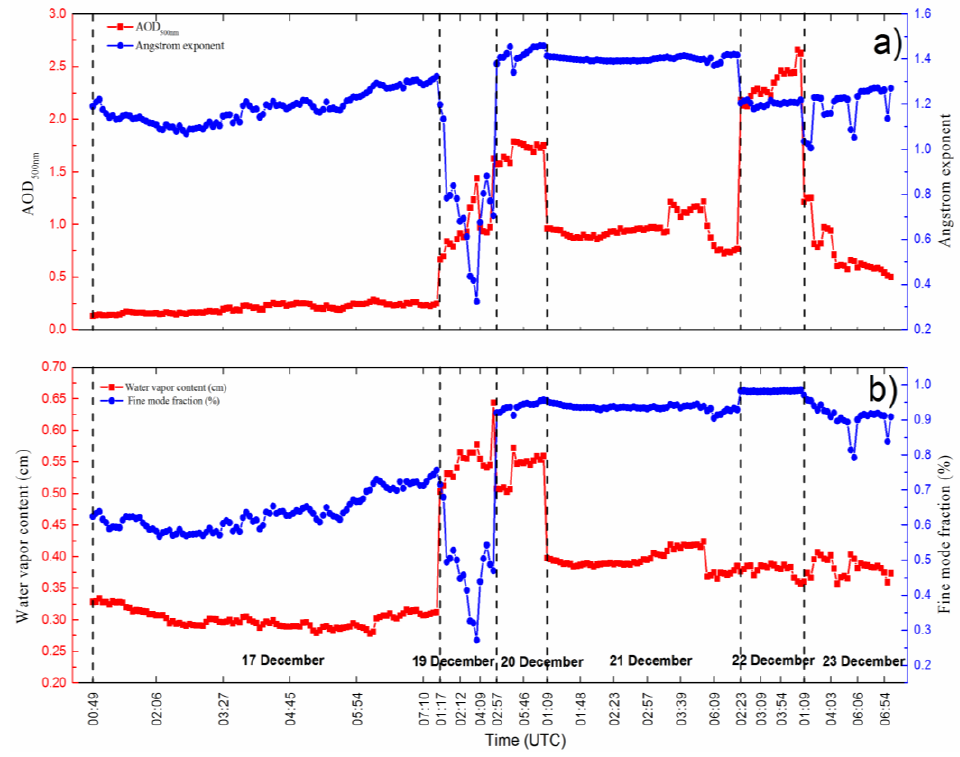
Figure 5. Daily variation of ( a ) AOD 500nm and AE; and ( b ) CWV and FMF (Level 1.5 aerosol inversions datasets).